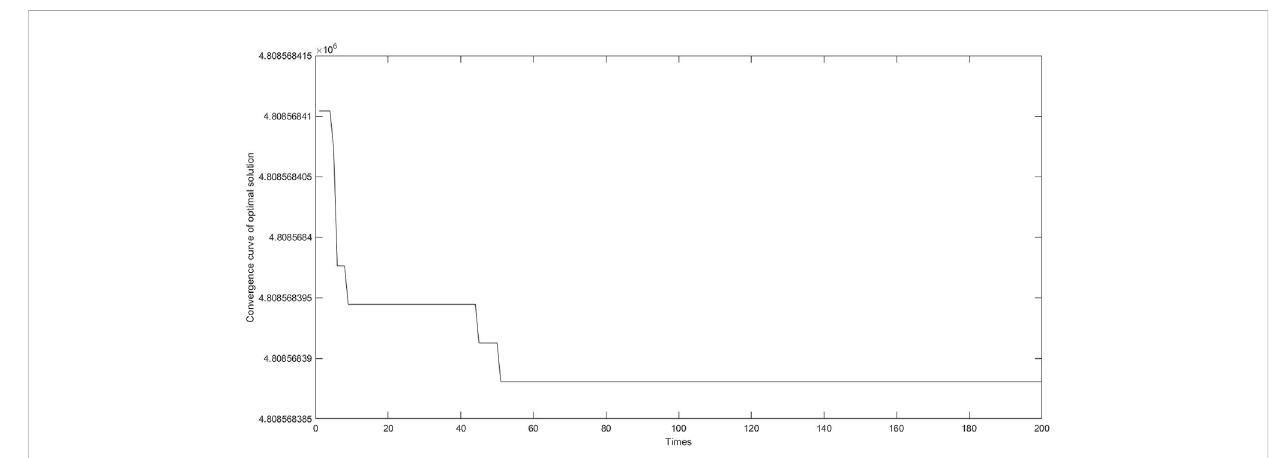
FIGURE 11 Optimal solution convergence graph.